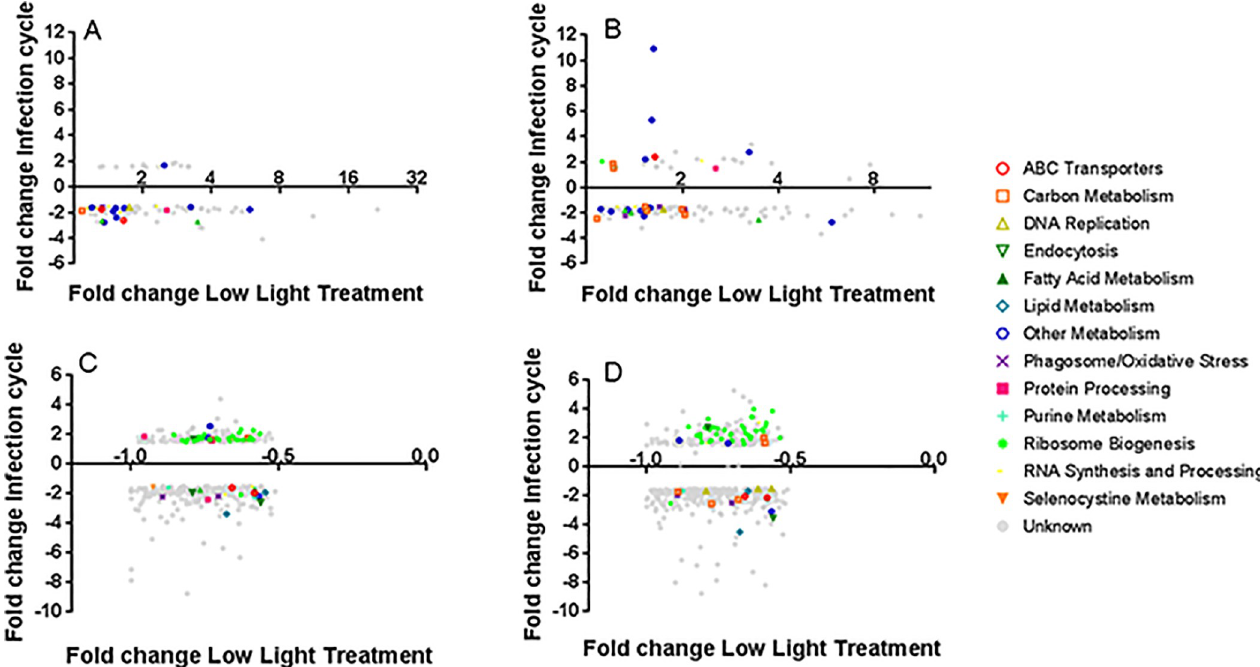
Fig 6. Comparison between de novo assembled Aureococcus anophagefferens CCMP1850 transcriptome in low light [25] and Aureococcus anophagefferens CCMP1984 transcriptome over the course of the infection cycle [11]. A) Significantly overexpressed genes detected in Frischkorn et al . Transcriptome compared to genes significantly over expressed during the early stages of the infection cycle (5 min, 30 min, 1 hr, 6 hr). B) Significantly overexpressed genes detected in Frischkorn et al . Transcriptome compared to genes significantly over expressed during the late stages of infection cycle (12 hr and 21 hr). C) Significantly underexpressed genes detected in Frischkorn et al . Transcriptome compared to genes significantly over expressed during the beginning of infection cycle (5 min, 30 min, 1 hr, 6 hr). D) Significantly underexpressed genes detected in Frischkorn et al . Transcriptome compared to genes significantly over expressed during the late stages of infection cycle (12 hr and 21 hr). The value for the fold change over the course of the infection cycle is the average of significantly differentially expressed fold change for either the early stages of infection (A, C) or the late stages of infection (B, D).